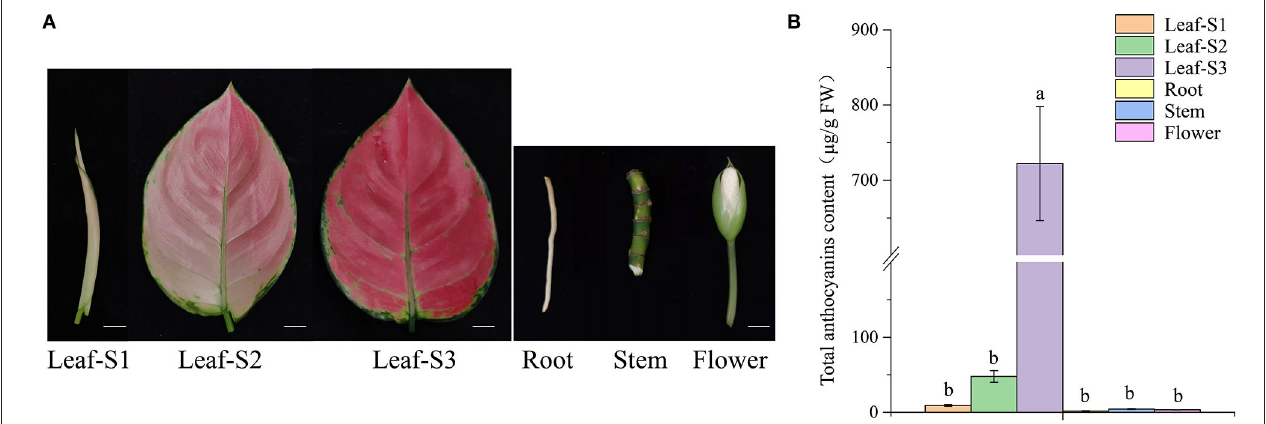
FIGURE 1 | Anthocyanin content in the leaves, at the three developmental stages; roots; stems; and flowers of Aglaonema commutatum “Red Valentine.” (A) The phenotypes of the leaves at the three developmental stages, S1, S2, and S3; roots; stems; and flowers. Bar: 1 cm. (B) Anthocyanin content in the different